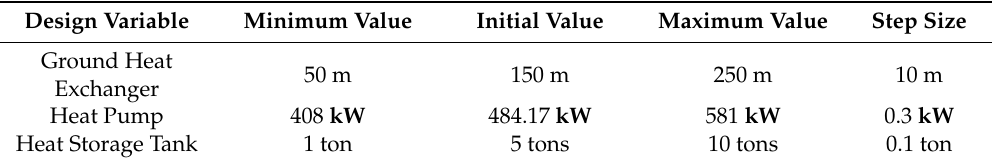
Table 5. Design values for